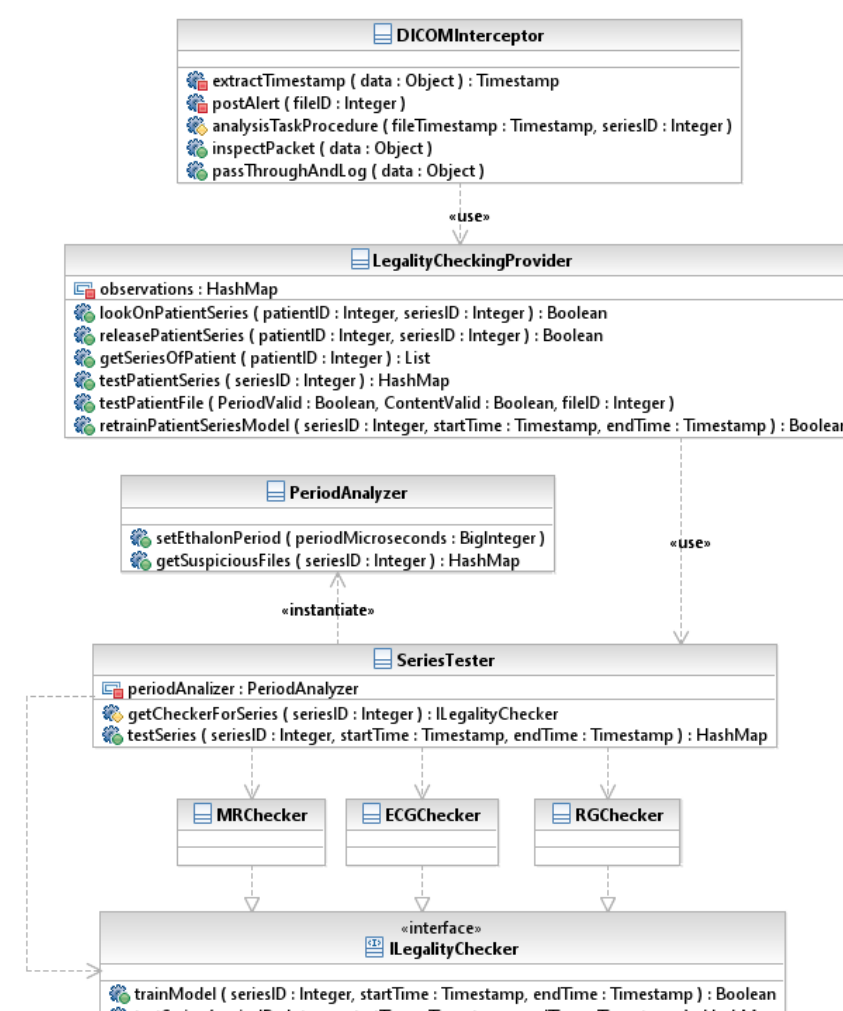
Figure 1. Class diagram of the component for medical data analysis.